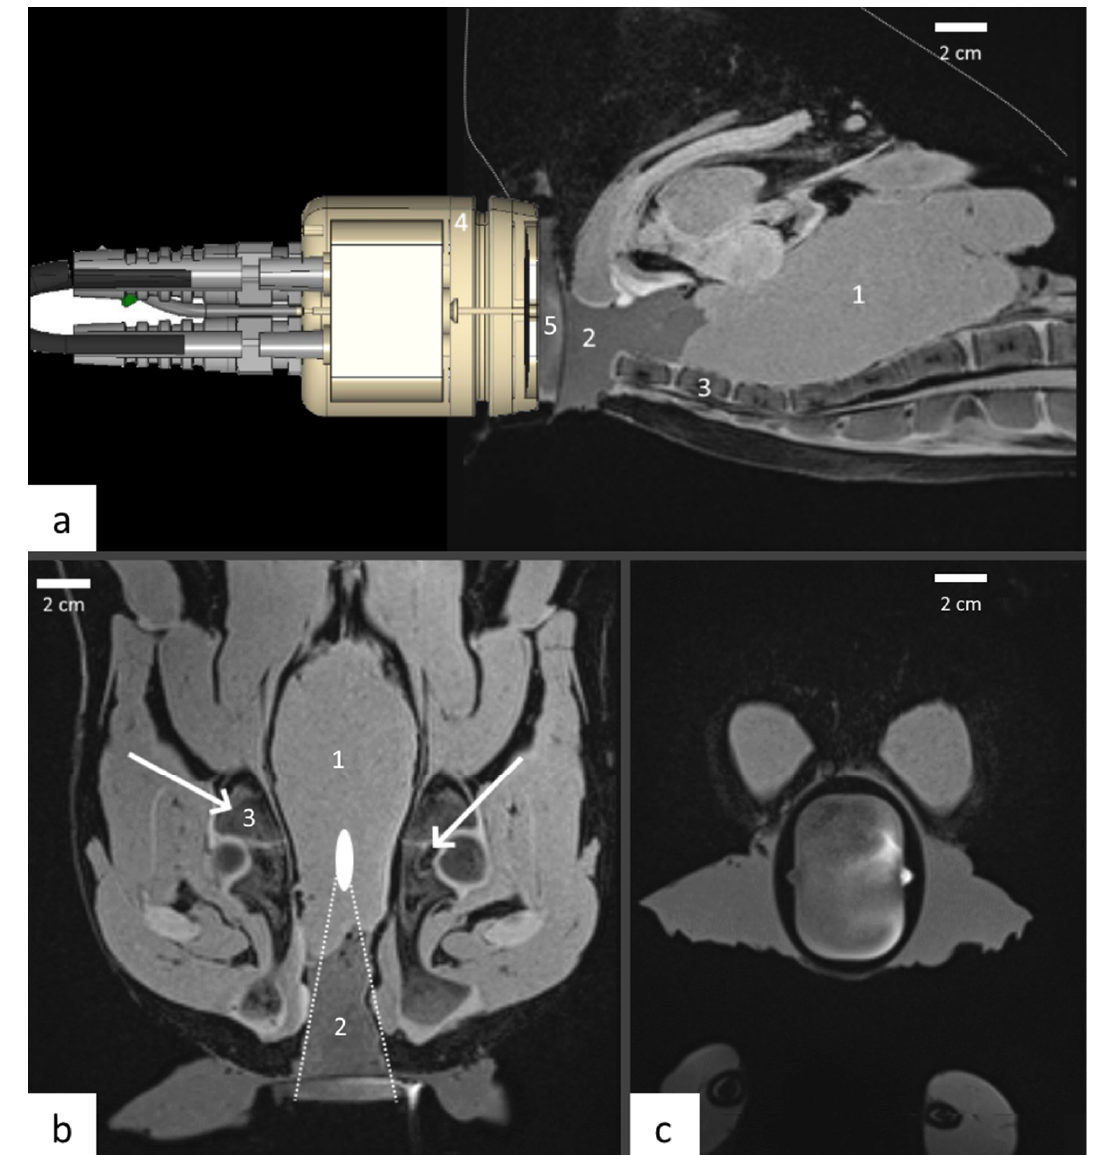
Figure 2. Positioning of the phased-array transducer on carcass lamb: ( a ) sagittal, ( b ) coronal and ( c ) axial sections in the T1w 3D GRE data. Transducer (4) was placed in the axis of the simulated target (1), the coupling between the target and the transducer was realized with standard ultrasonic gel (2) and the water flow compartment in front of the applicator (5). A special attention was paid to thermal energy deposition on bone (3) that is indicated with white arrows.